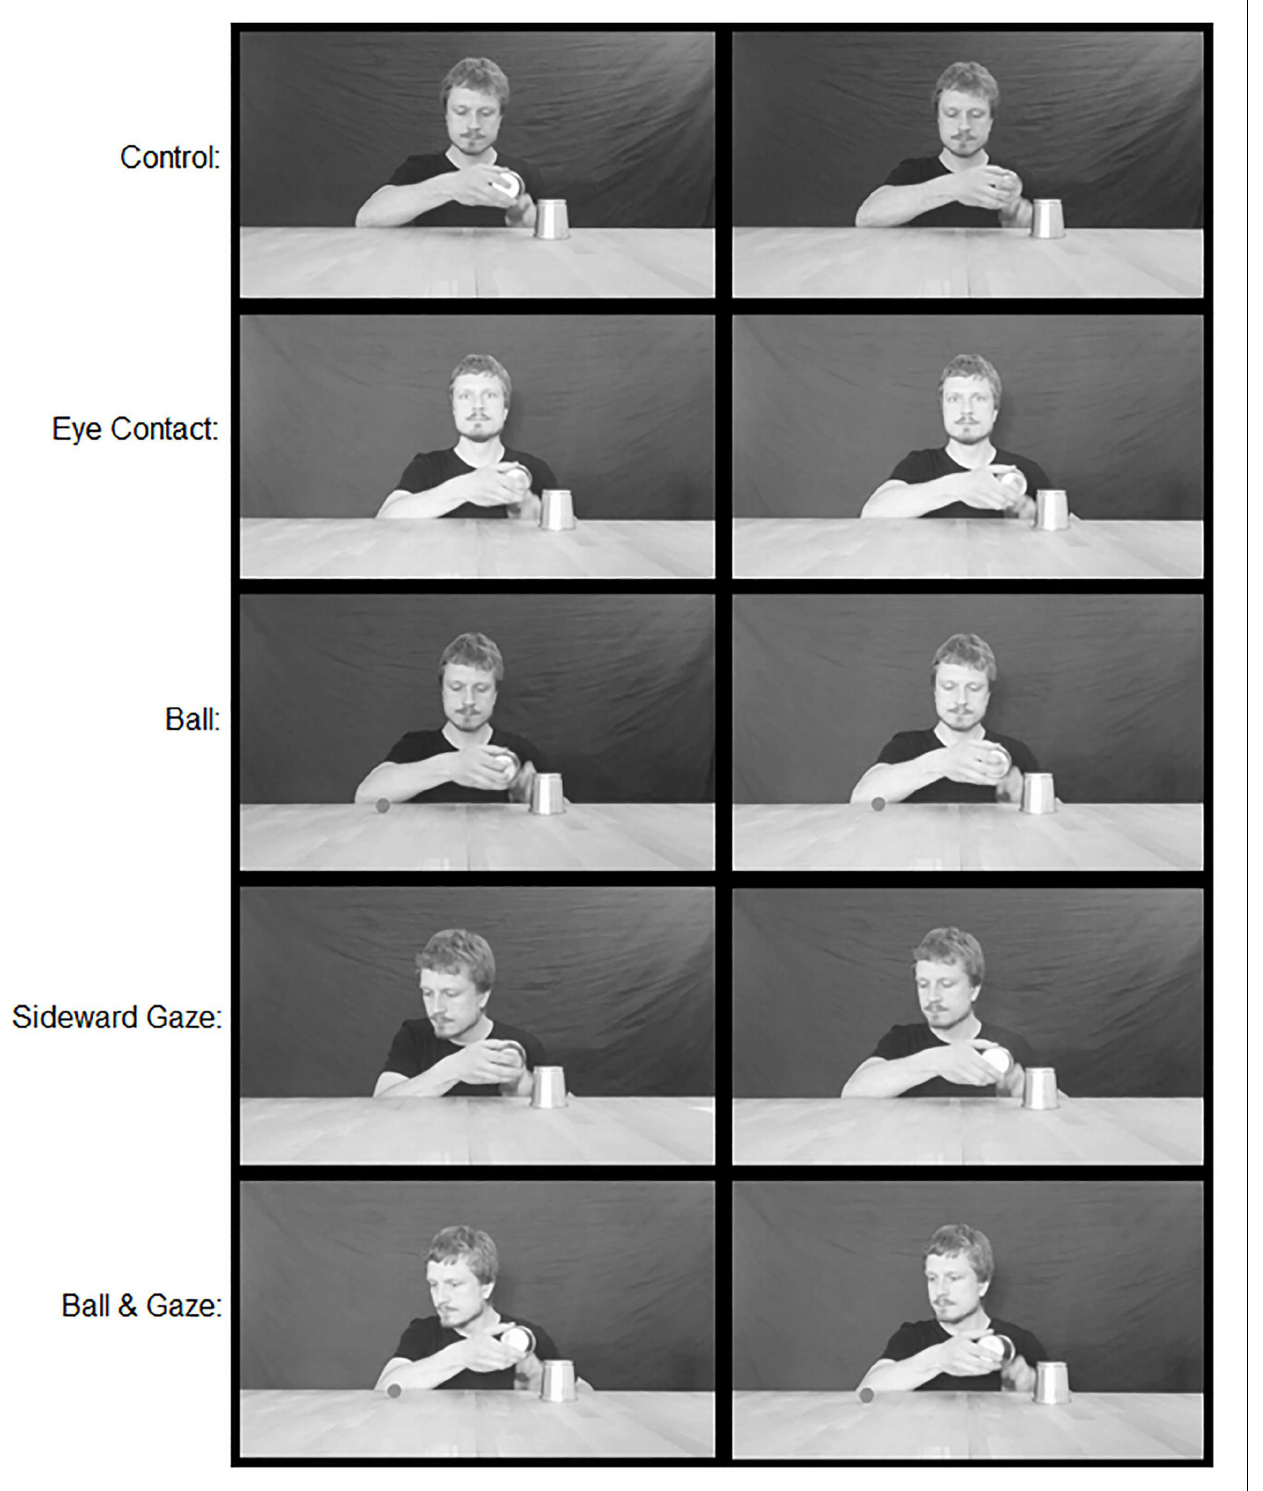
FIGURE 2 | Depiction of the moment of the loading of the green ball (i.e., the trick mechanism to be detected) in all of the videos used in the experiment. Each row represents a different experimental condition. The two images in each row show the critical event in both versions of the videos that were combined to form an experimental